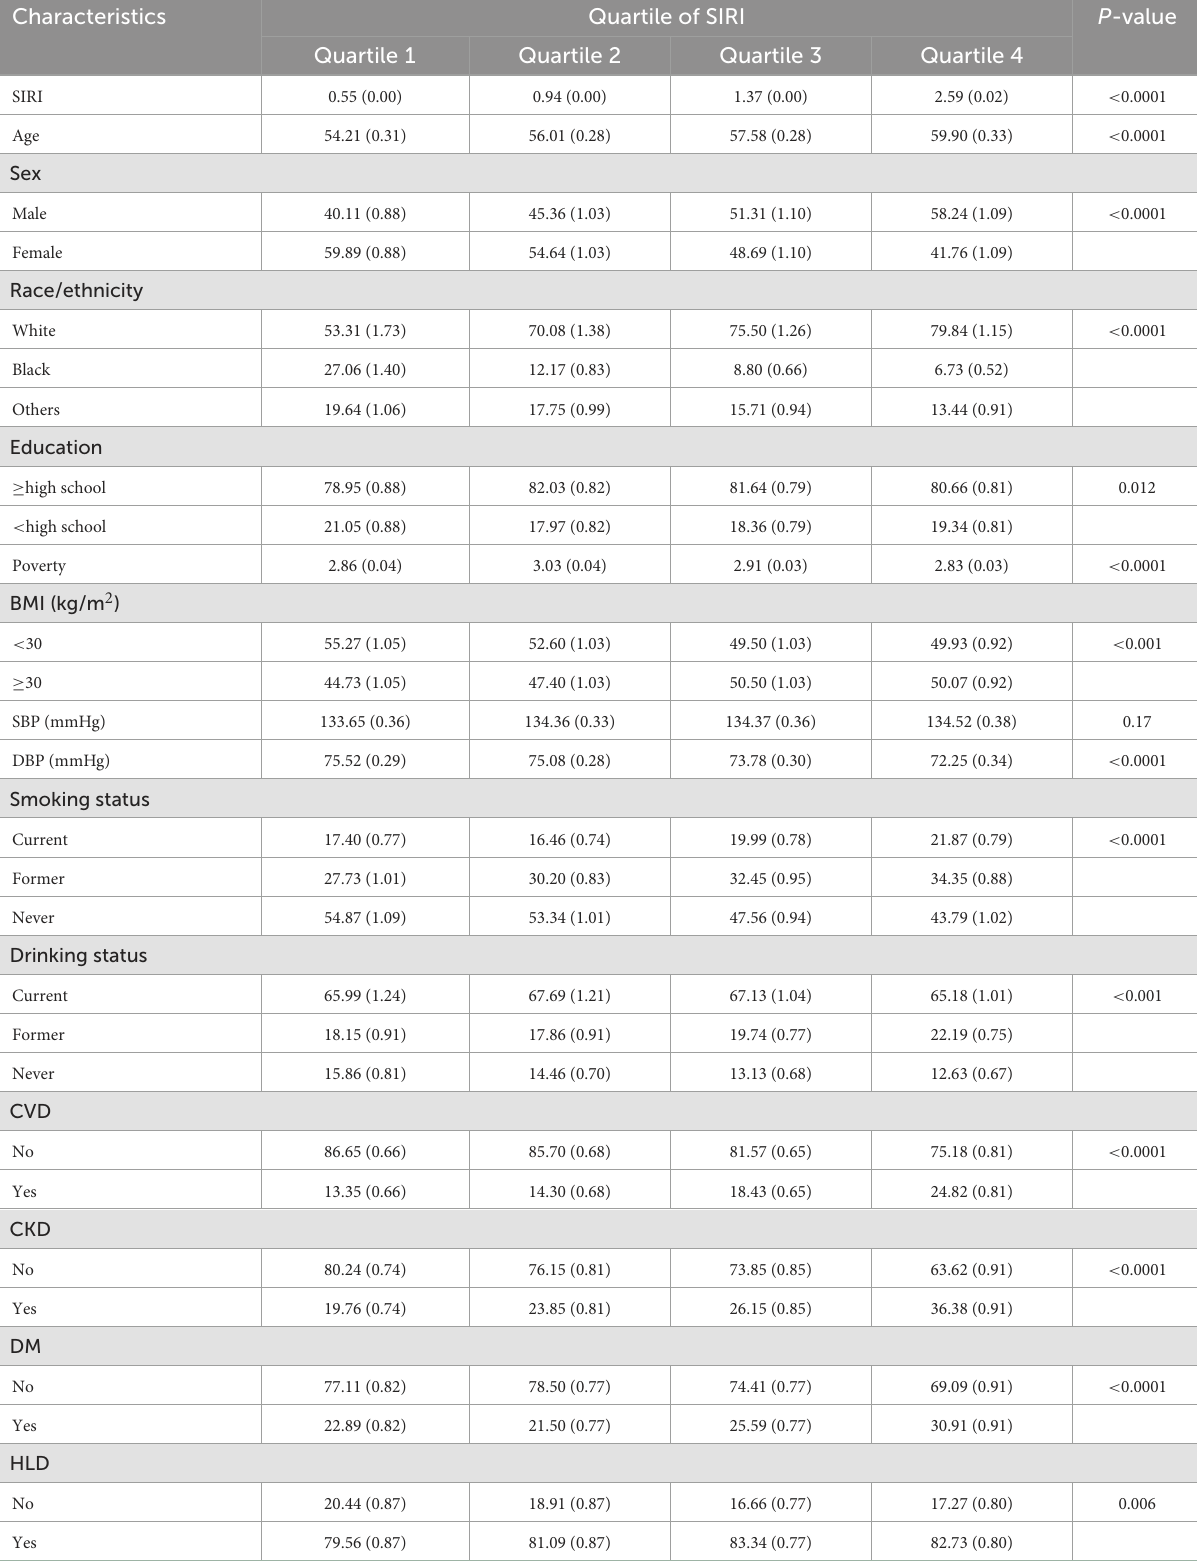
TABLE 1 Weighted baseline characteristics of participants with hypertension according to SIRI